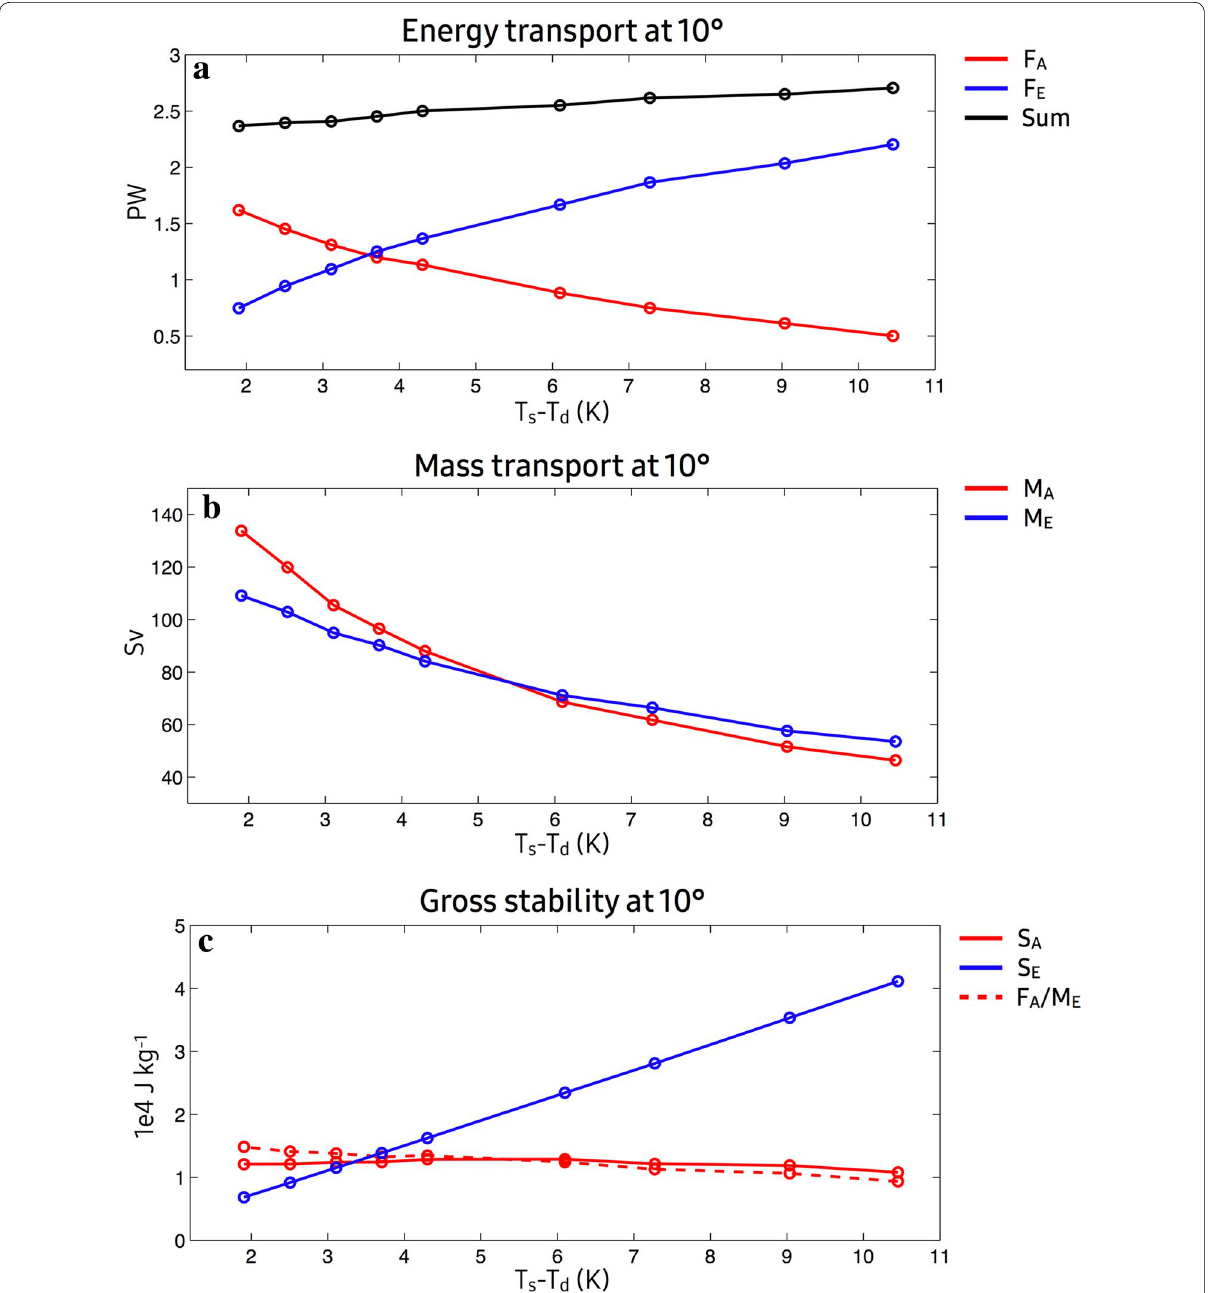
Fig. 2 a The meridional energy transport by the atmosphere F A (red), the Ekman flow F E (blue), and the sum (black) in PW, b the meridional mass transport by the atmosphere M A (red) and the Ekman flow M E (blue) in Sv, and c the gross stability of the atmosphere S A approximate estimate F A / M E (red dashed), and that of the Ekman flow S E computed as the average of the absolute values at 10°S and